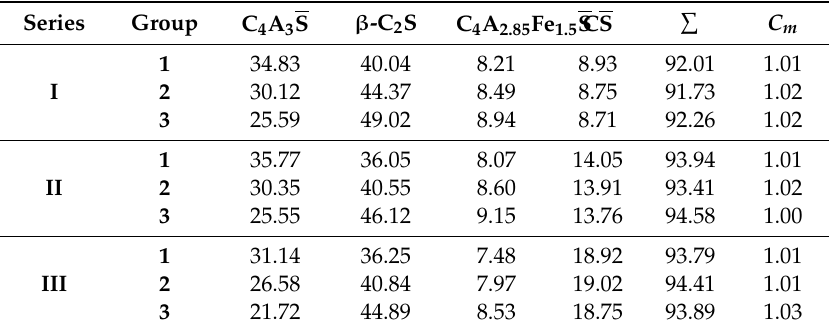
Table 4. Mineral content, wt.% and alkalinity coe ffi cient of the cement